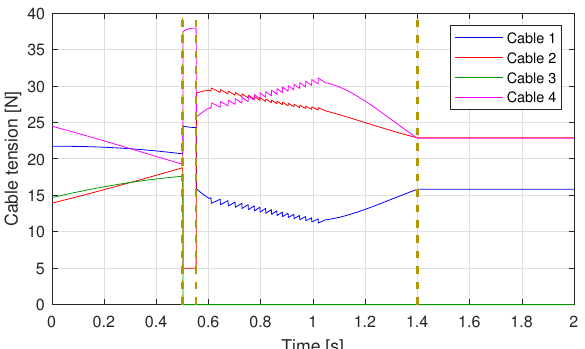
Figure 12. Cable tension during the recovery approach for cable 1 ( blue ), cable 2 ( red ), cable 3 ( green ) and cable 4 (violet).